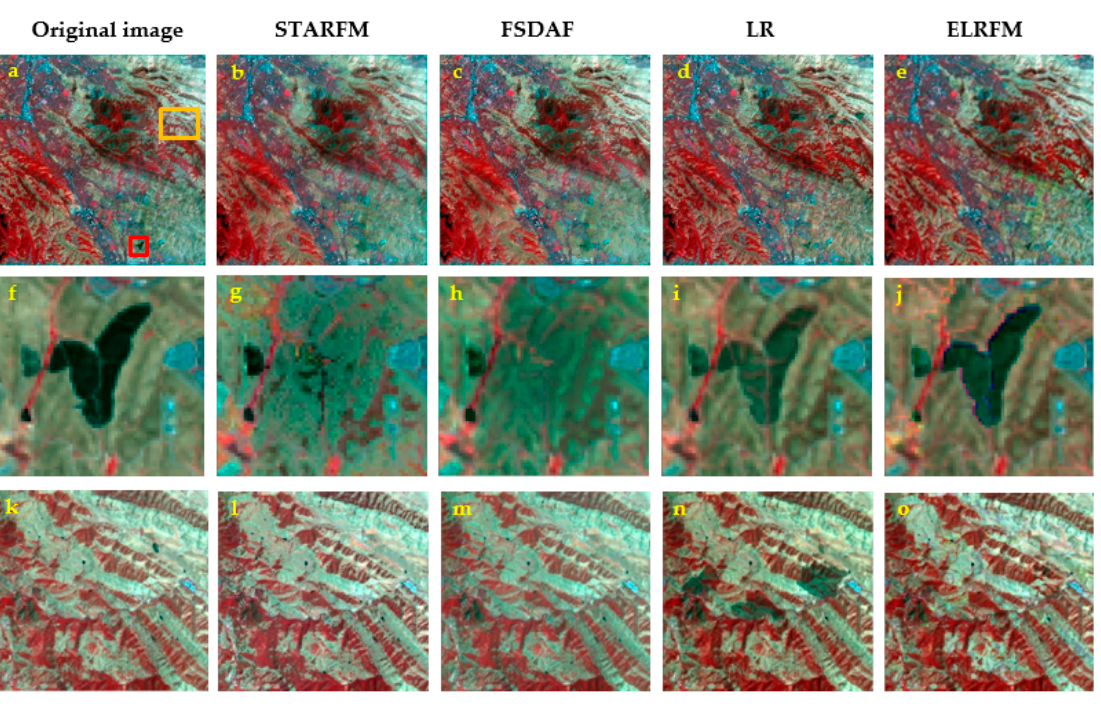
Figure 5. Color composited image (RGB: near-infrared, red, green) results from four spatio–temporal fusion methods: ( a ) reference image at t 2 ; ( b ) spatial and temporal adaptive reflectance fusion model (STARFM); ( c ) flexible spatio–temporal data fusion method (FSDAF); ( d ) linear regression (LR); ( e ) ELRFM. The images at ( f – j ) and ( k – o ) are the corresponding zoomed-in sub-region images bounded by the red and yellow rectangles in ( a ), respectively.